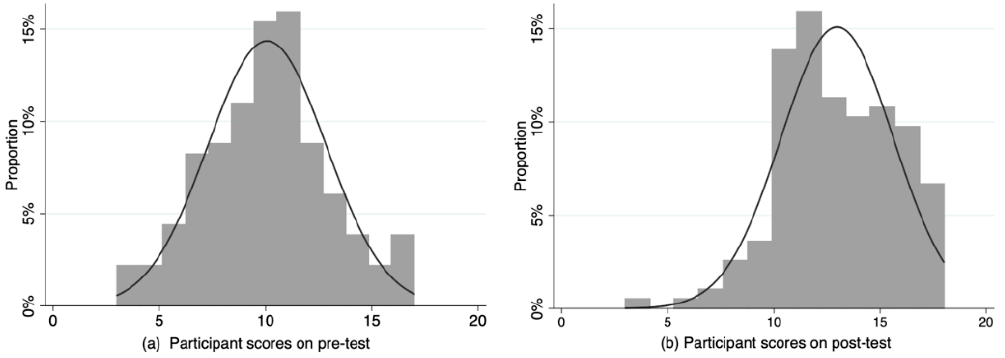
Figure 3. Histogram with a bell curve of participant scores ( a ) on the pre-test and ( b ) on the post-test.